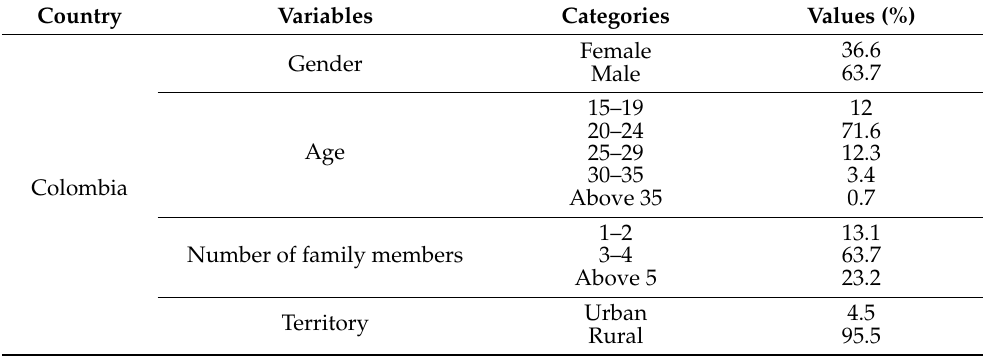
Table 2. Cont. Country